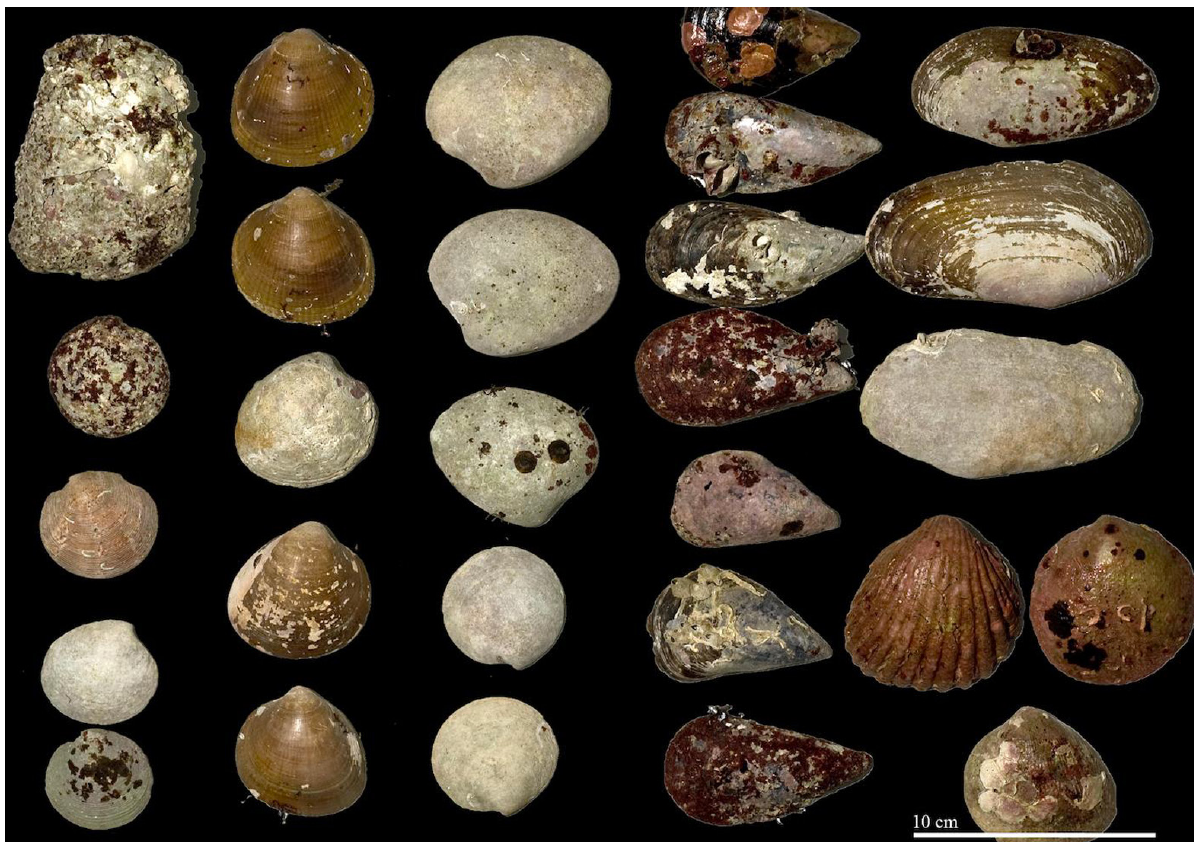
Fig. 4. – Samples of very long established bivalve shells found in one of the O. vulgaris midden piles located on the sandy bottom of the Rodas inlet